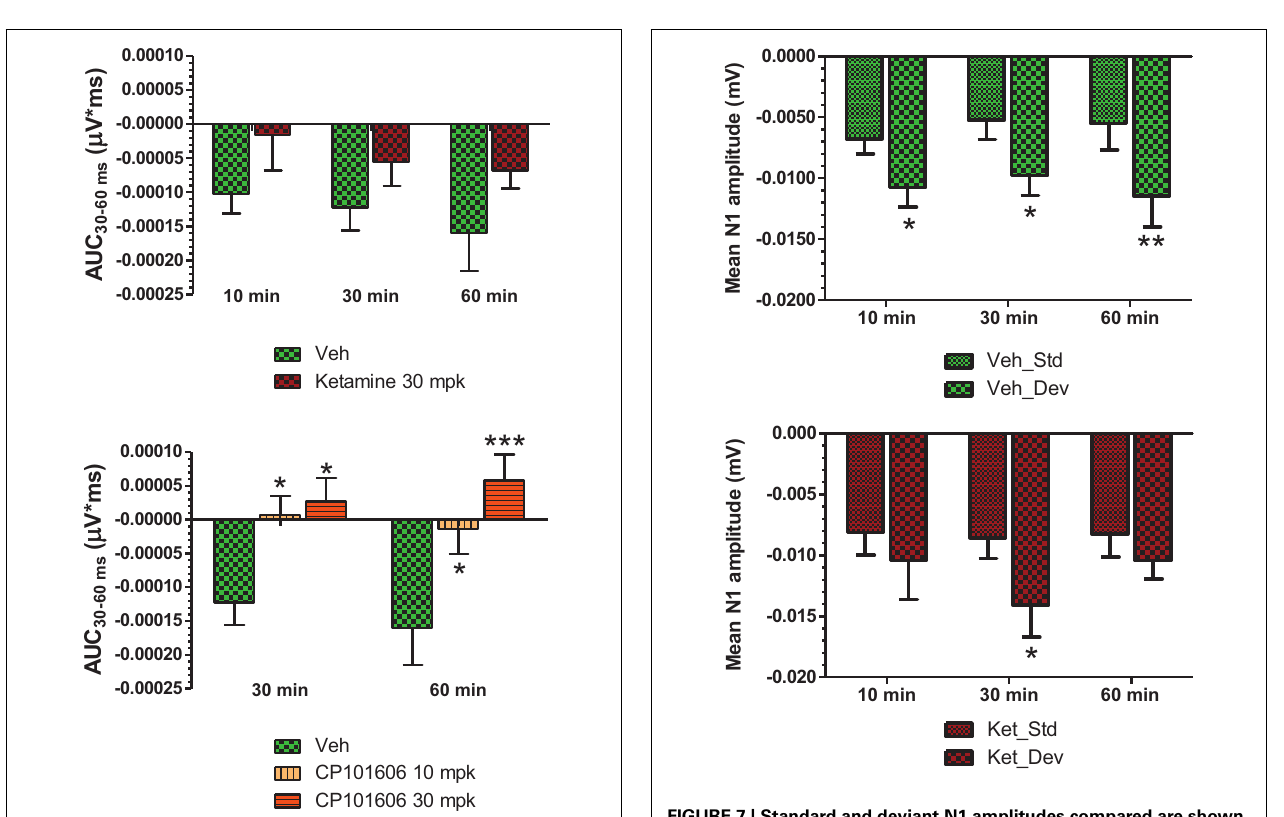
FIGURE 7 | Standard and deviant N1 amplitudes compared are shown . Top panel summarizes post-vehicle responses across three time points. Two-way ANOVA with repeated measures showed a robust effect of condition (standard or deviant) on N1 response [ F (1) = 27.85; P < 0.0001]. Bottom panel shows post-ketamine data. A significant condition effect was noted [ F (1) = 6.82; P = 0.012]. */**Indicate significant treatment effect ( P < 0.05/0.01 respectively; Bonferroni